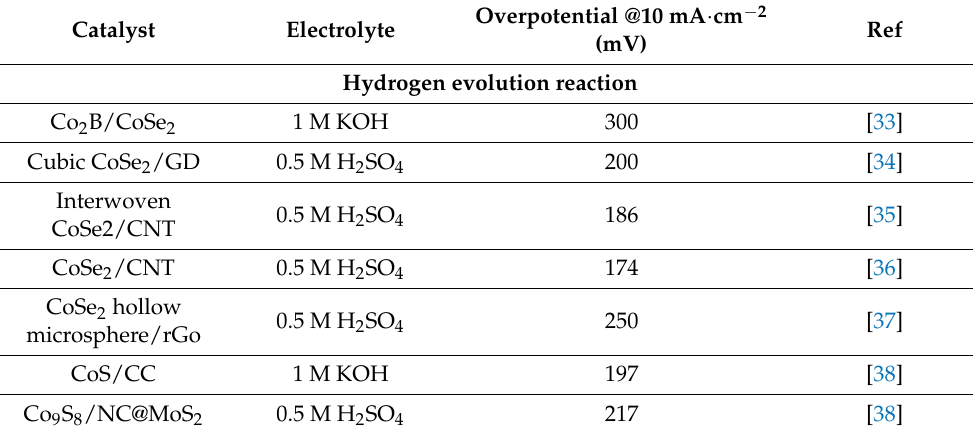
Table 1. Comparison of HER and OER performance of Co@NC catalyst with reported non-precious transition metal-based